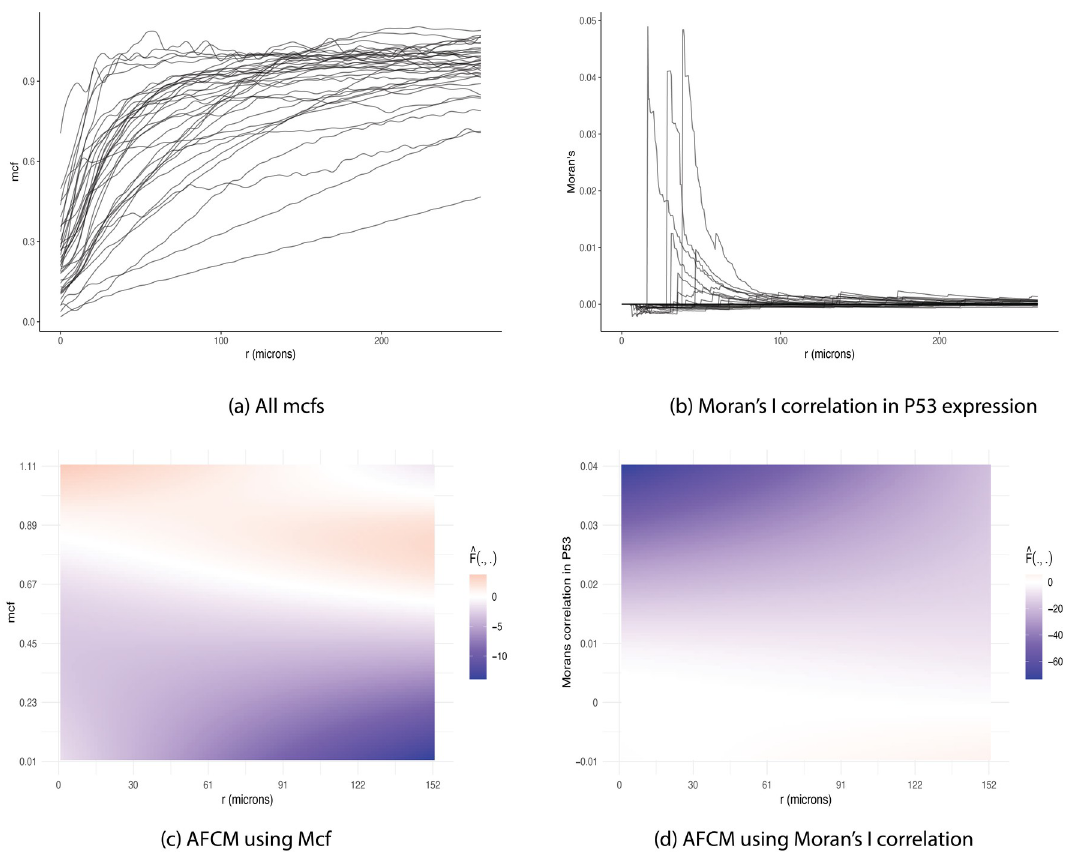
Fig 6. TNBC dataset. (A) Mark connection functions (mcf) for the tumor—immune cell distributions for all subjects in TNBC dataset. Dashed horizontal line represents mcf under complete randomness. Mcf values below 1 indicate strong clustering of cells of same type, while values above 1 suggest higher level of mixing in of the two cell types. (B) Moran’s I correlation between tumor and immune cells across subjects using P53 marker expression. Moran’s I values above 0 indicate a direct relationship in P53 expression between tumor and immune cells. Negative Moran’s I values suggest an inverse association in P53 expression between tumor and immune cells. (C) Estimated surface from AFCM using mcf curves as functional covariates, with values decreasing from positive (red) to negative (blue). Positive ^ F corresponds to increased risk of mortality while negative ^ F associates with reduced hazard of death. The more immune cells surrounding tumor cells across all distances (i.e., mcf values > 1), the higher risk of mortality (i.e., ^ F > 0 ). (D) Estimated surface from AFCM using Moran’s correlation in P53 expression between tumor and immune cells, with values of ^ F decreasing from positive (red) to negative (blue). Weak positive correlation in P53 expression between tumor and immune cells across all distances associates with a declined in risk of mortality with ^ F < 0